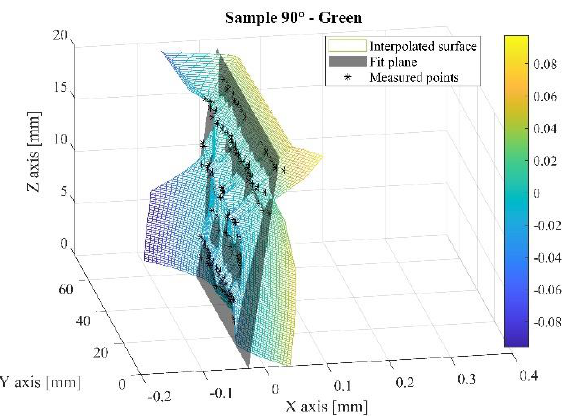
Figure 8. Sample 90°, points measured at the green state and reconstruction of the plane. Figure 8. Sample 90 ◦ , points measured at the green state and reconstruction of the